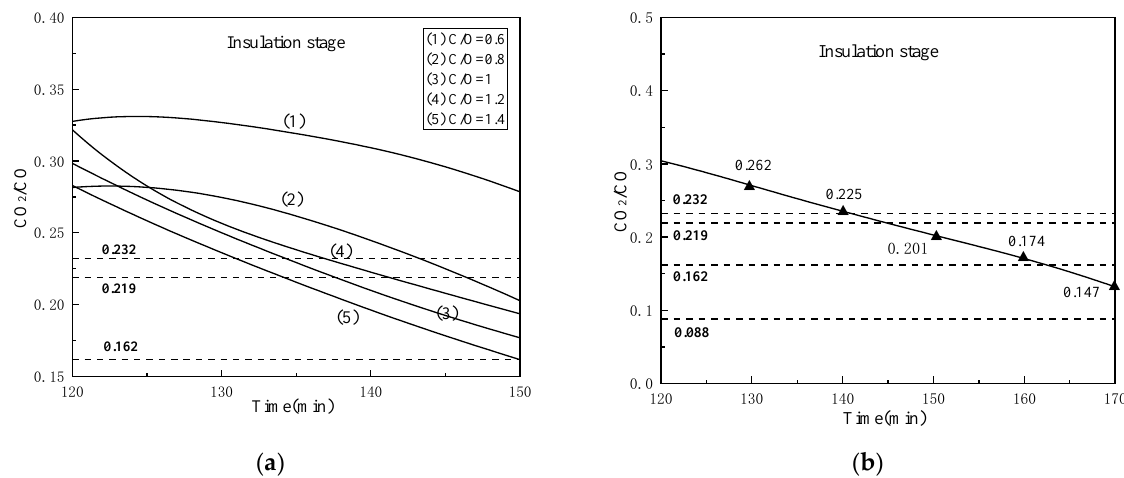
Figure 14. Changes of CO 2 /CO value under different conditions: ( a ) 1000 °C, 30 min and different coal ratios and ( b ) 1000 °C, C/O = 1 and different reduction holding time.